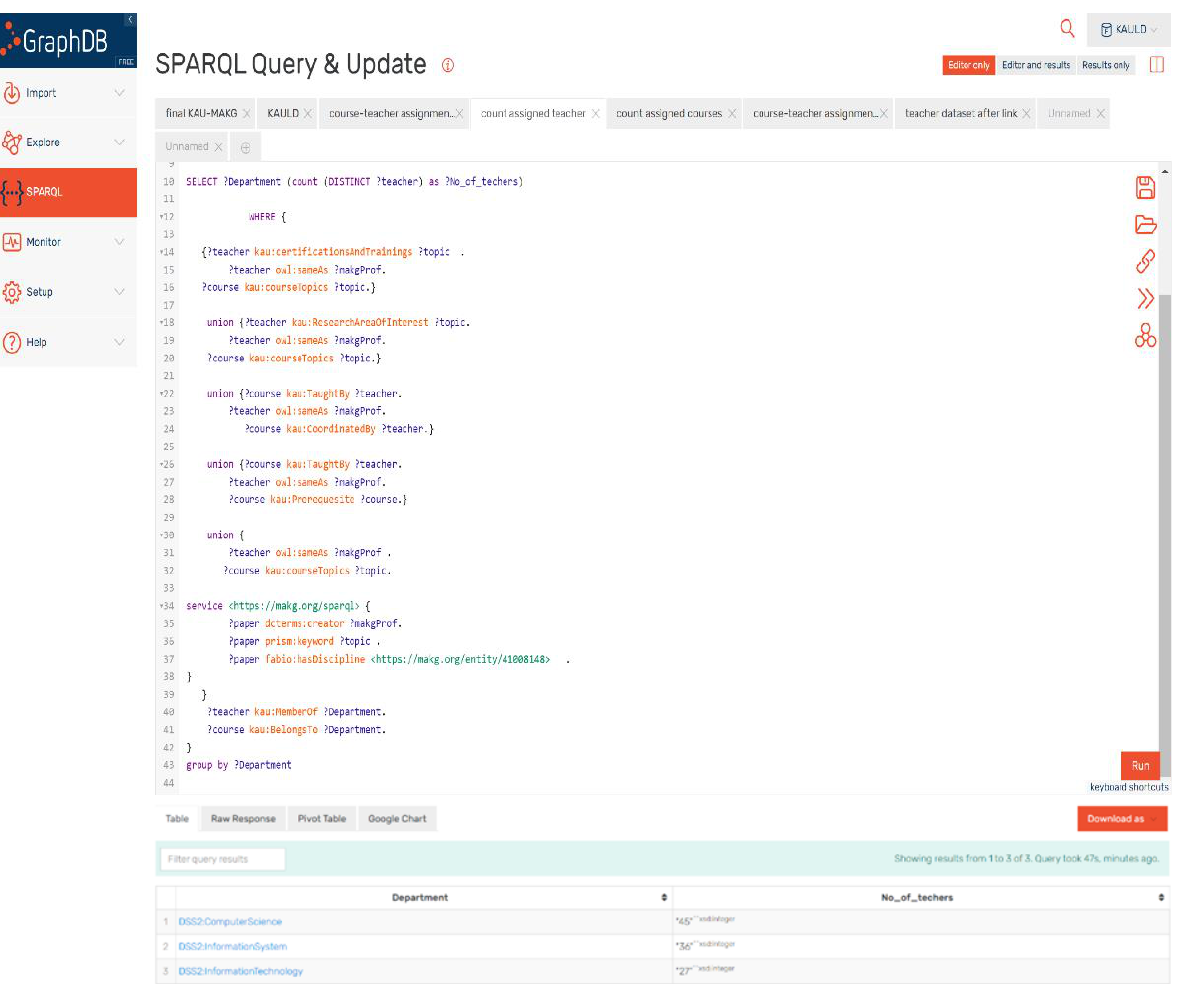
Figure 16. Comparing number of courses assigned to teachers using LD to the total number of courses.